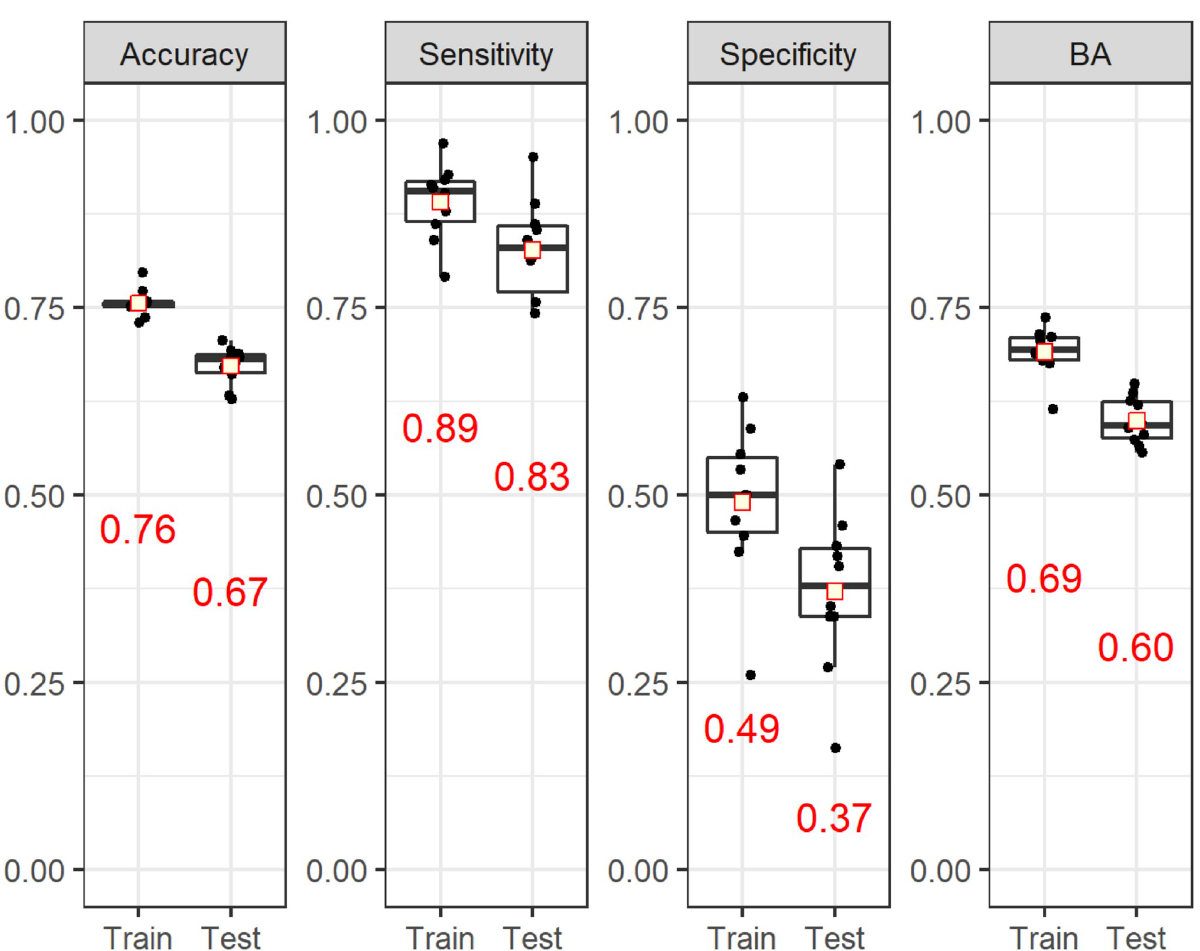
Fig 2. The performance of the classification models. The accuracy, sensitivity, specificity and BA were calculated from 10 trials of decision tree analysis with 5-fold cross-validation and are shown as box plots. The red numbers and squares represent the means of 10 trials with each value as black dots. Train, training set; Test, test